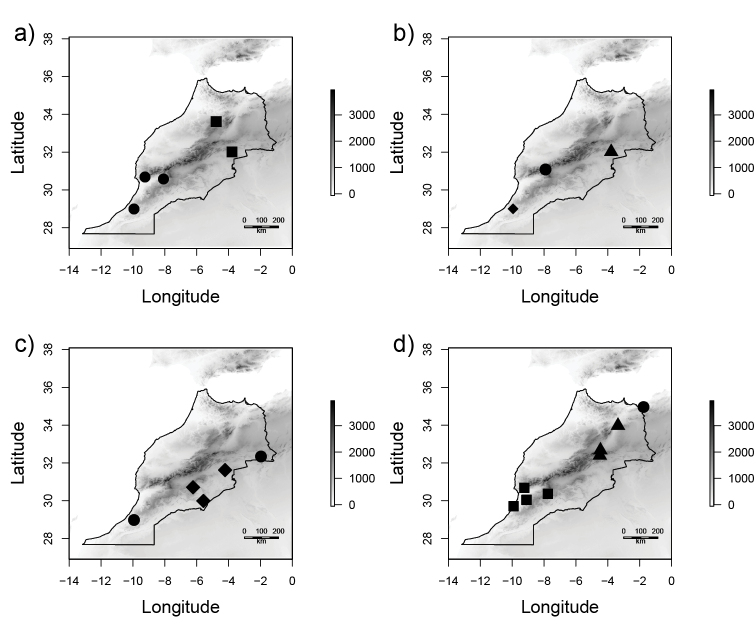
Distribution of sampling locations of newly described species AAndrena
hebescens (circles), Andrena
semiadesus (squares) BAndrena
tenebricorpus (diamond), Andrena
niveofacies (circle), Andrena
triangulivalvis (triangle) CAndrena
sparsipunctata (circles), Andrena
breviceps (diamonds) DAndrena
acutidentis (squares), Andrena
farinosoides (triangles), Andrena
nigriclypeus (circle). Relief is indicated by shading, measured in meters above sea level.